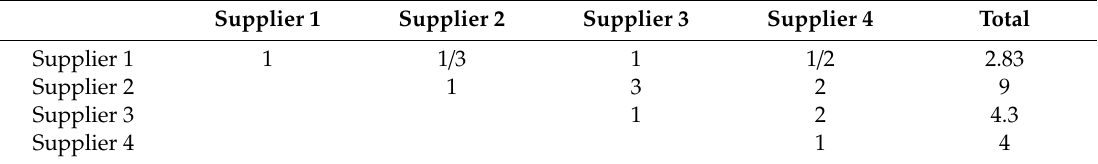
Table 8. The results of pairwise comparison for supplier alternatives with regard to support services